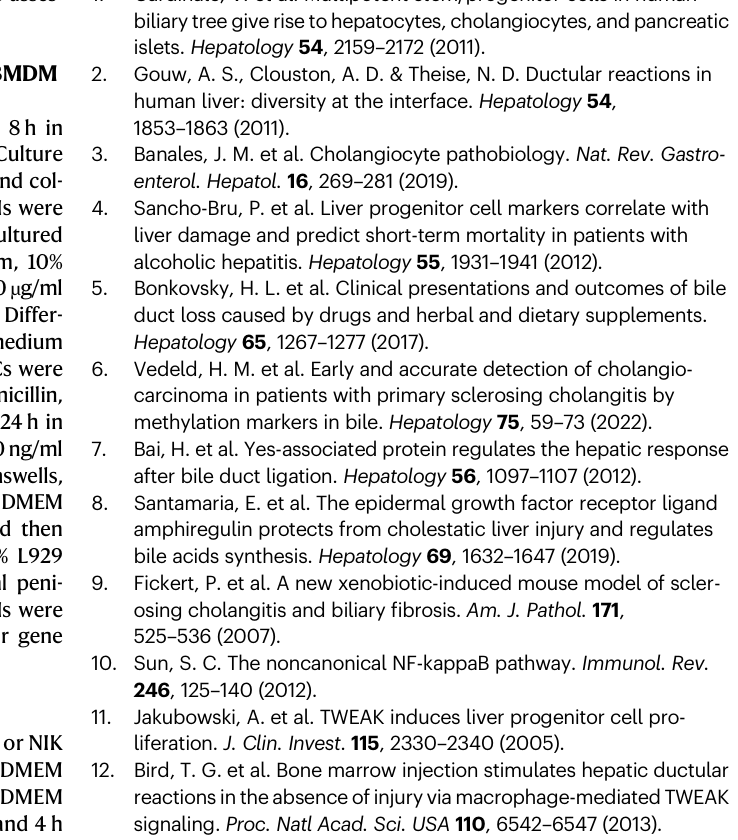
were separated by SDS-PAGE and immunoblotted with the indicated antibodies. Antibodies were listed in Supplementary Table 1. HEK293 cell lines were from the ATCC